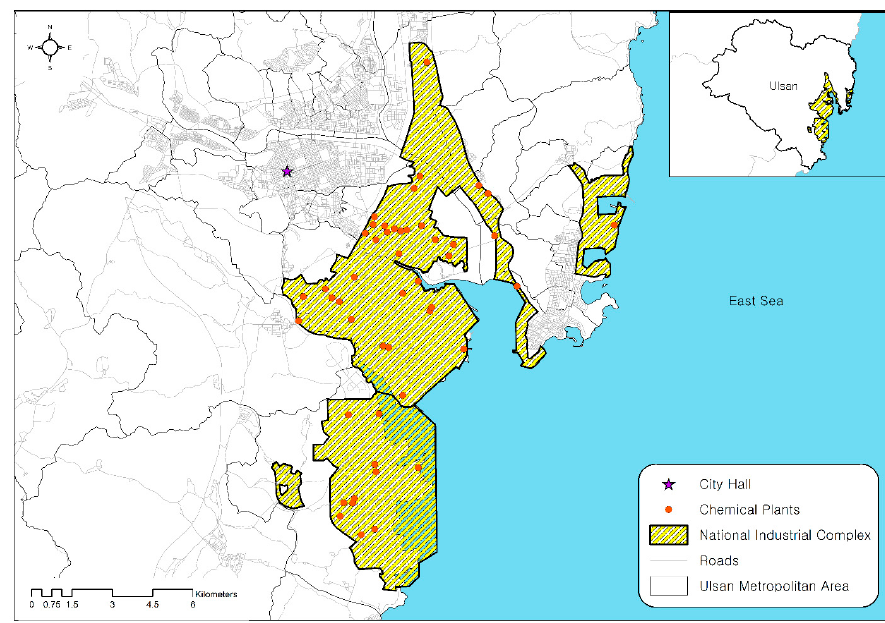
Figure 1. National industrial complexes and 51 chemical plants located within Ulsan.